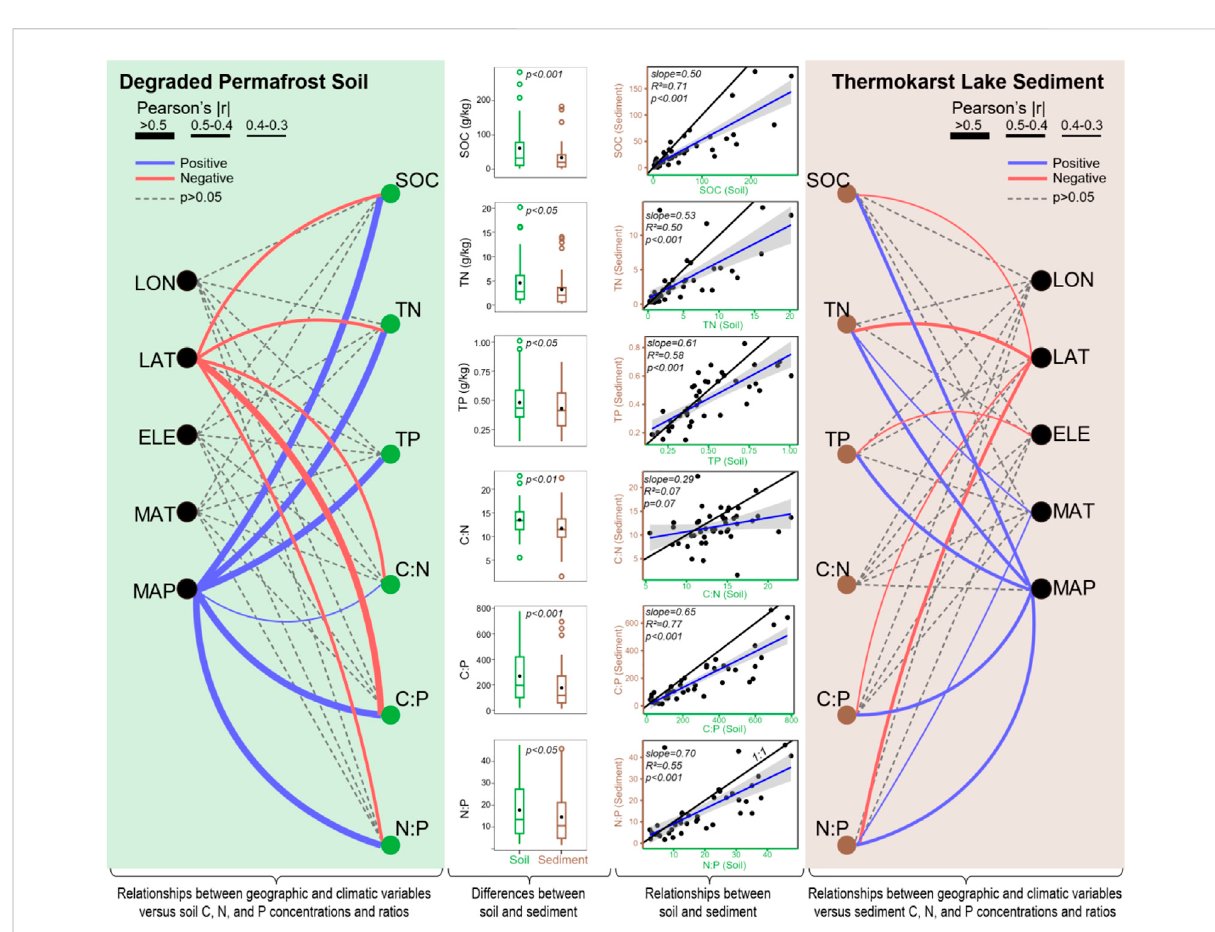
FIGURE 3 The summary of the patterns of soil/sediment organic carbon (SOC), total nitrogen (TN), and total phosphorus (TP), as well as C:N:P ratios in permafrost soil and thermokarst lake sediment. The lines on the left and right panels show the relationships between geographic (LON: longitude, LAT: latitude, ELE: elevation) and climatic (MAT: mean annual temperature, MAP: mean annual precipitation) variables versussoil/sediment C, N, and P concentrations and ratios. The box plots in the middle show the differences between soil and sediment, tested using paired t -test. The linear regression plots in the middle show the relationships between soil and sediment. The black solid line represents the 1:1